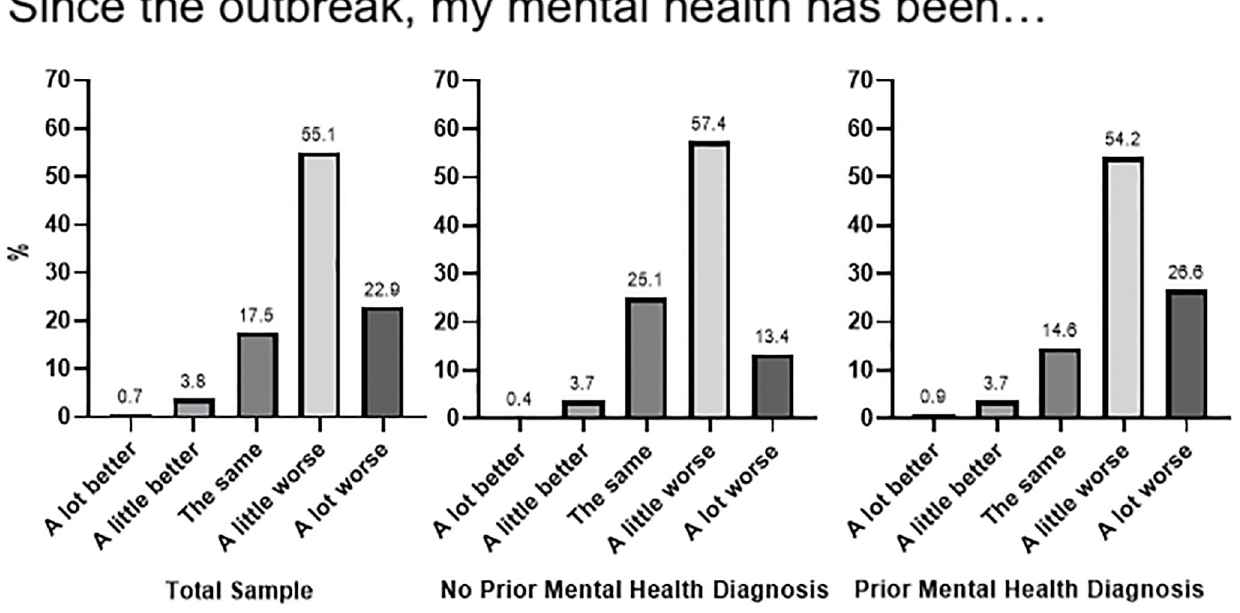
Fig 1. Proportion of participants reporting how their mental health has been since the start of the COVID-19 outbreak, in the total sample (Left), the sub-sample with a prior mental health diagnosis (middle) and no prior mental health diagnosis (right).